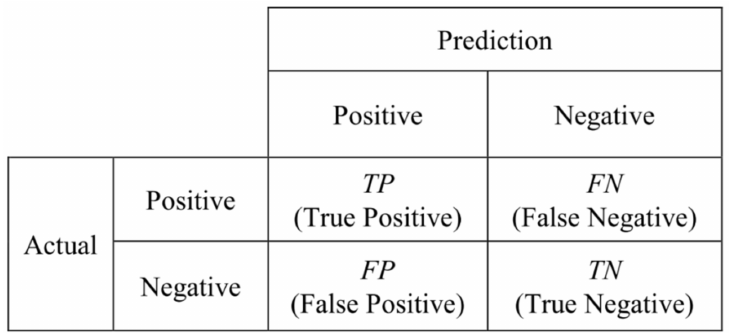
Figure 17. Confusion